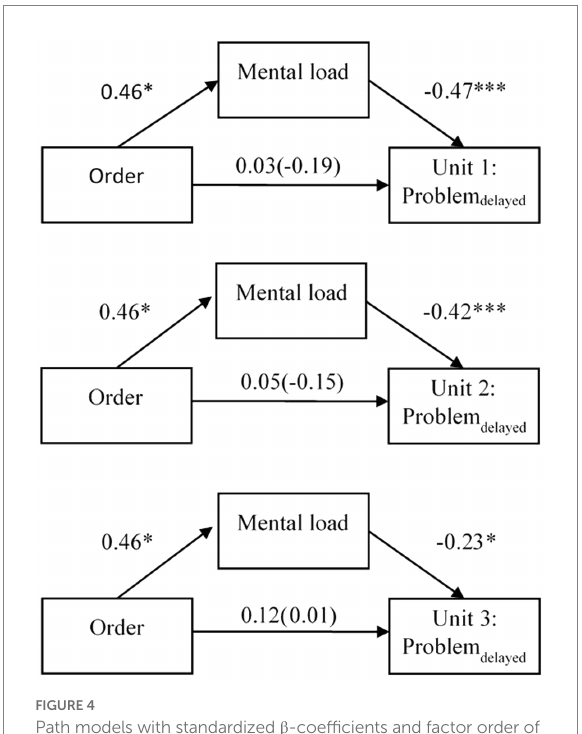
FIGURE 4 Path models with standardized β -coefficients and factor order